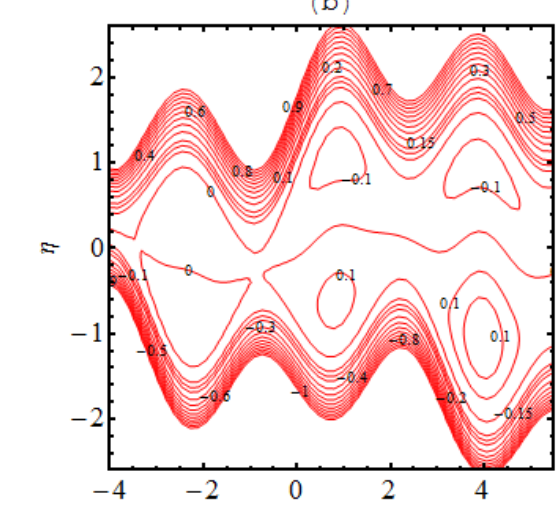
Figure 7. Stream lines for ( a ) 𝑚 (cid:2869) = 0.0 and ( b ) 𝑚 (cid:2869) = 0.1 where the other parameters are 𝛼 (cid:2870) = 0.1, 𝑘 = 3.0,𝐻𝑎 = 3.0, 𝑞 = −0.1,𝑚 = 1.0 and 𝛼 (cid:2869) = 0.05.